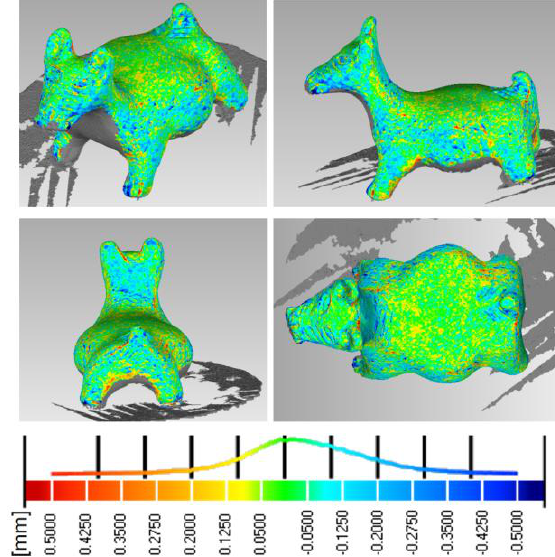
Figure 11. Comparison to fringe projection